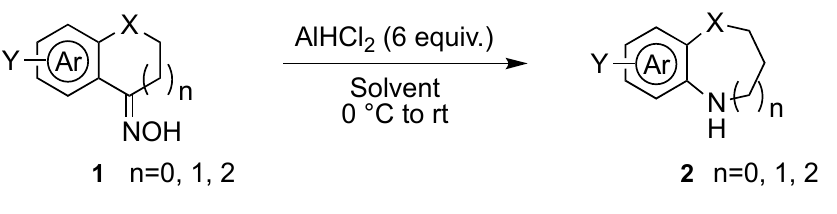
Table 2. Rearrangement of oxime with dichloroaluminum